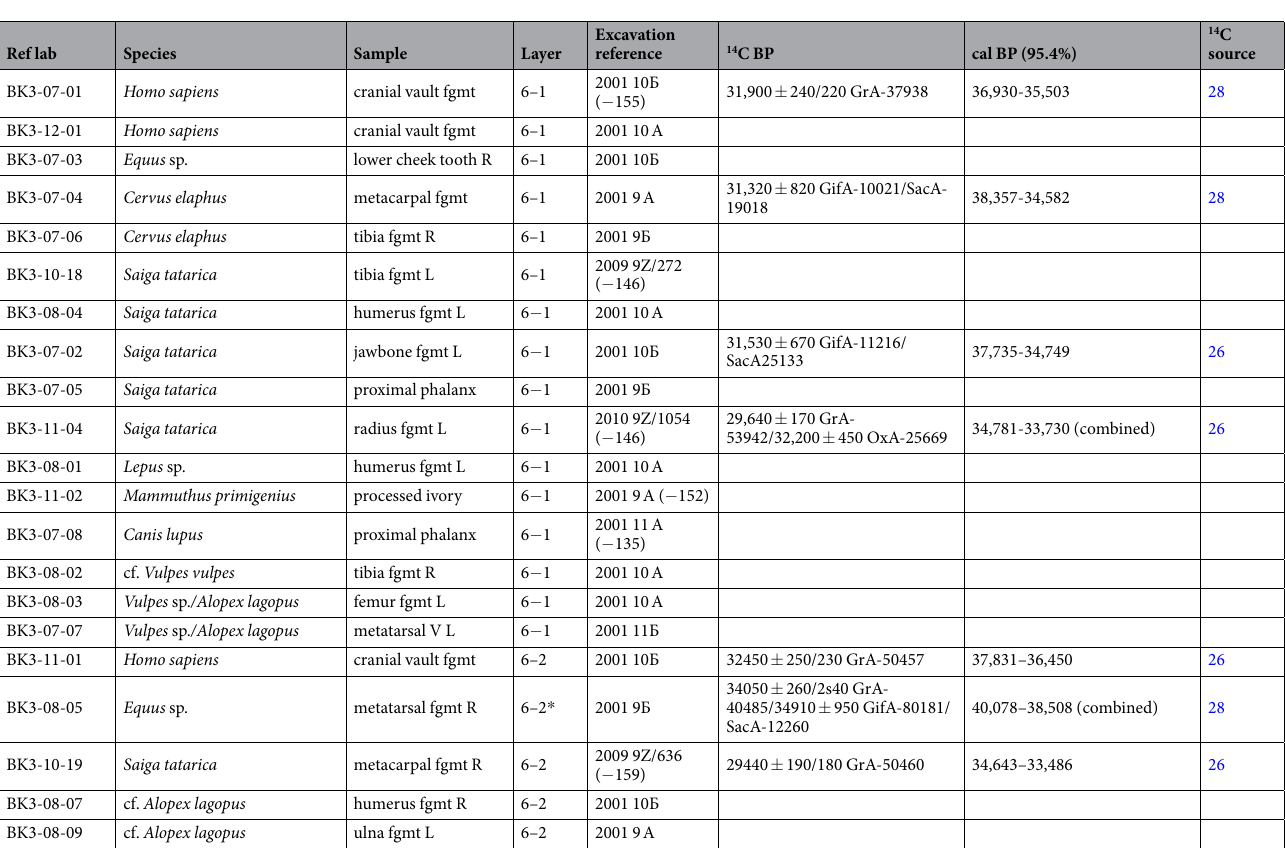
Table 1. List of the sampled bone specimens from Buran-Kaya III and related radiocarbon dates. Excavation reference corresponds to year square/object, field number and depth in cm; fgmt stands for fragment, L for left and R for right. * Indicates that the former stratigraphy position is now questioned based on the direct radiocarbon date (possible re-attribution to 6–3 26